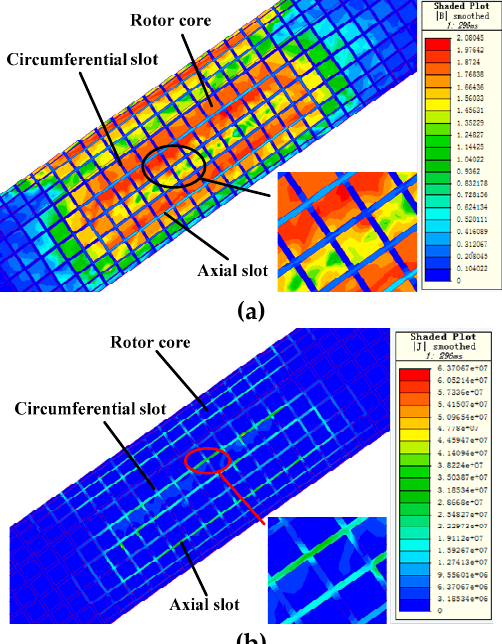
Figure 11. Magnetic field and eddy current field distributions: ( a ) Magnetic field; ( b ) Eddy current field.